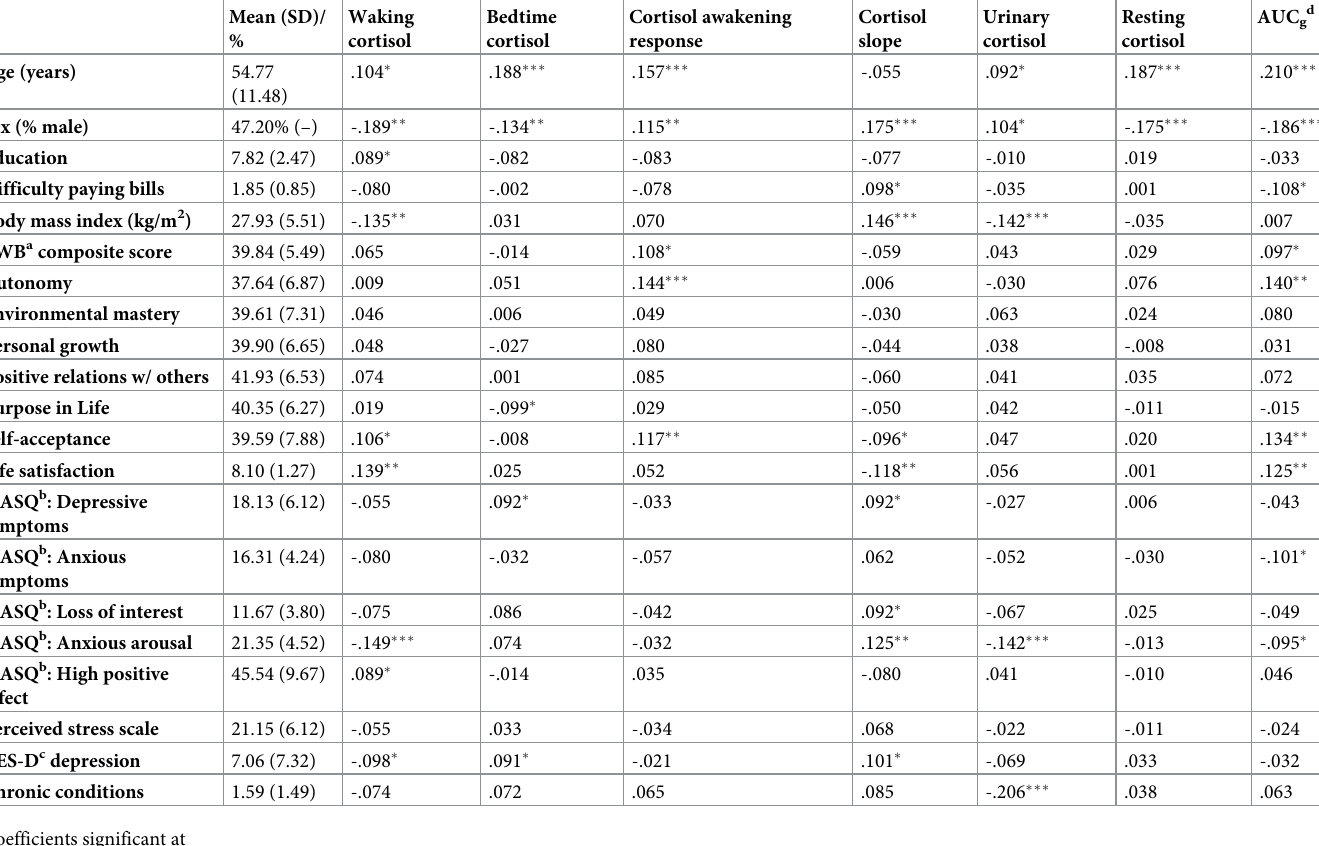
Table 2. Participant characteristics, psychosocial and physical health factors, and their correlations with the cortisol indices (N =